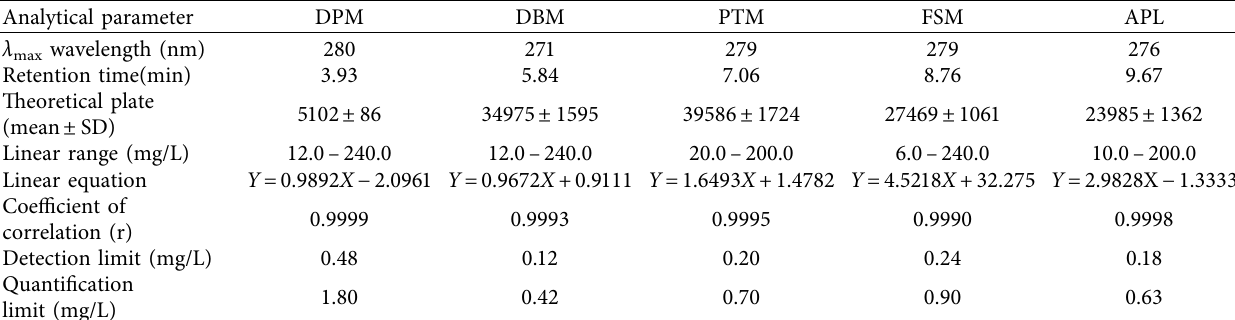
Figure 3: Overlaid UV absorption spectrum of FSM, DPM, DBM, PTM, and APL. Table 1: Analytical parameters for DPM, DBM, PTM, FSM, and